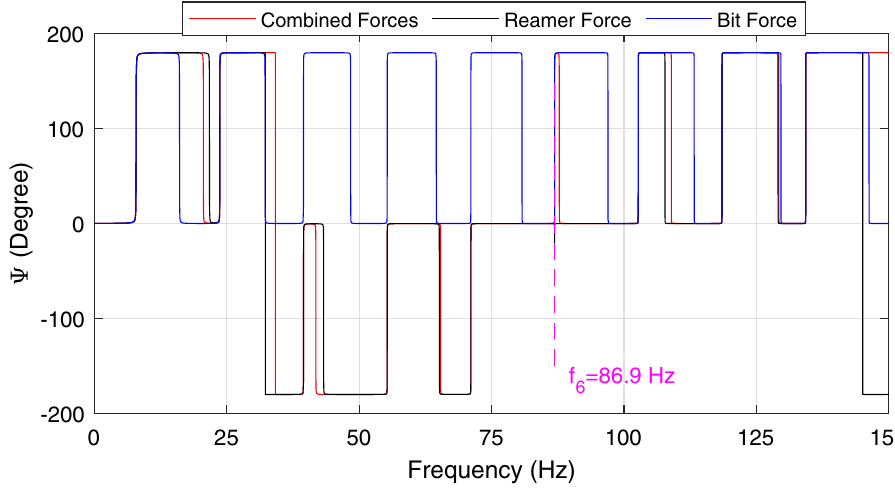
Fig. 6 Phase frequency response due to torque at the bit, torque at the reamer, and combined torques of the bit and the